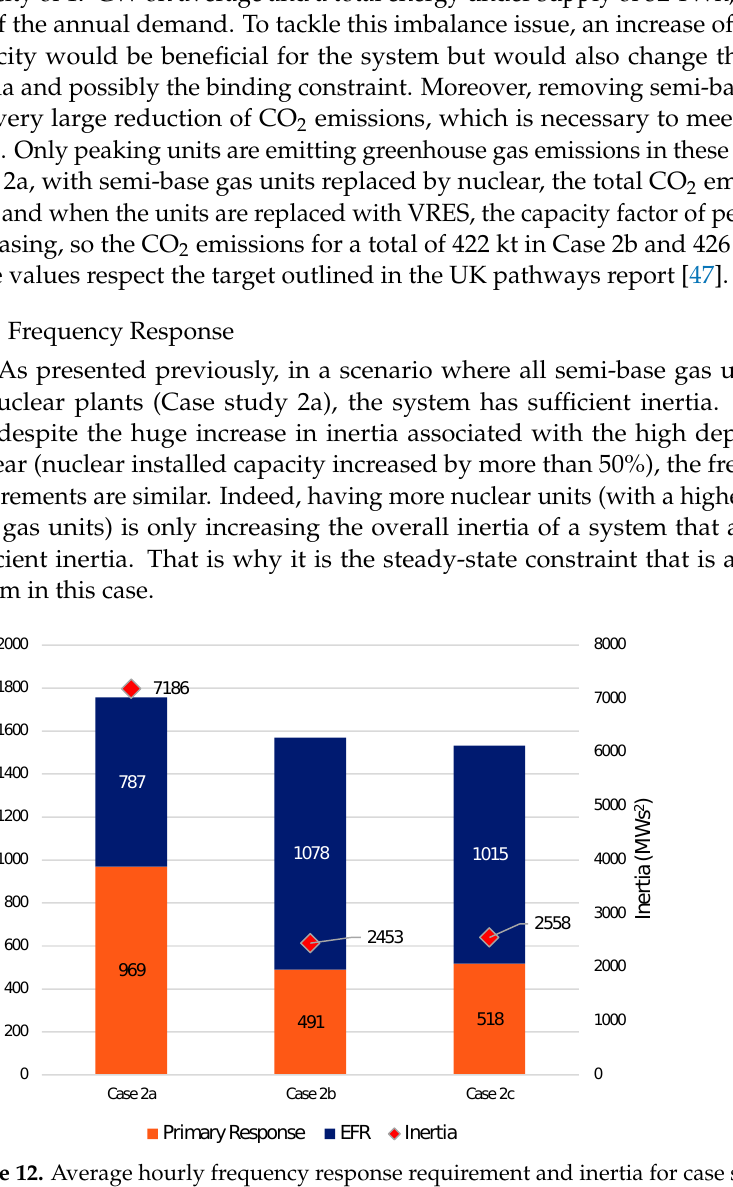
Figure 12. Average hourly frequency response requirement and inertia for case study